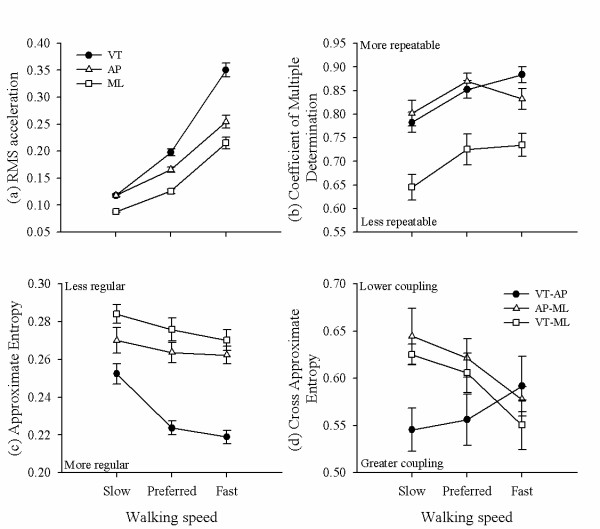
RMS acceleration (a), Coefficient of Multiple Determination (b), and Approximate Entropy (c), derived from lower trunk accelerations in the vertical (VT), anterior-posterior (AP), and mediolateral (ML) direction. Cross Approximate Entropy (d) representing strength of coupling between accelerations in the vertical and anterior-posterior (VT-AP), anterior-posterior and mediolateral (AP-ML), and vertical and mediolateral (VT-ML) directions. All data is presented for slow, preferred, and fast walking speeds. Error bars represent one standard error of the mean.